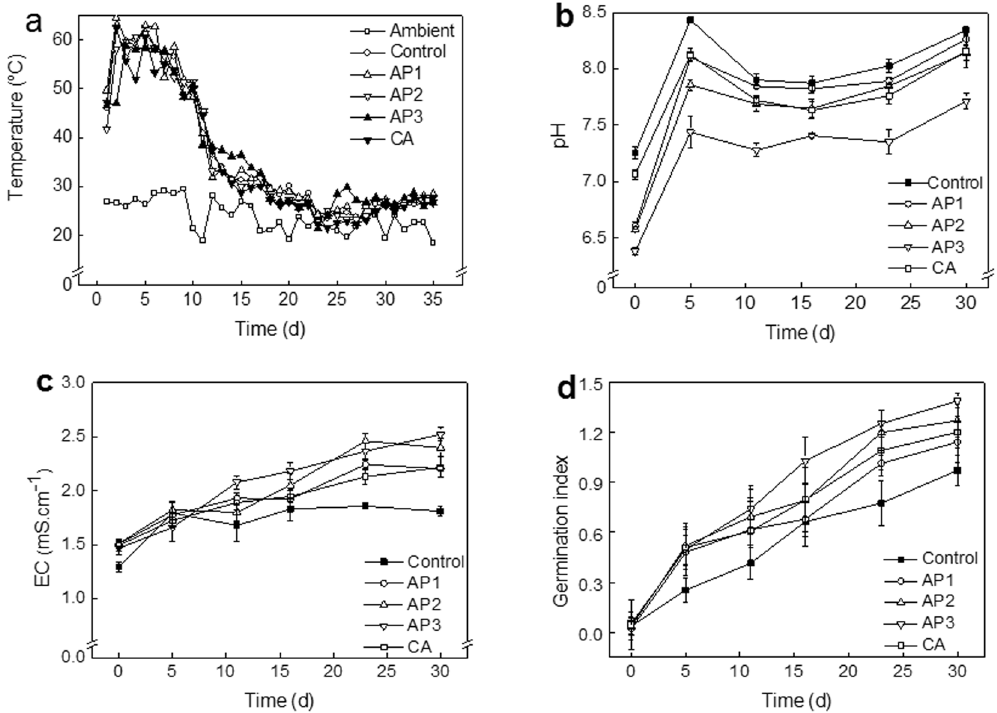
Figure 1. Profiles of temperature ( a ), pH ( b ), EC ( c ), and germination index ( d ) during the composting